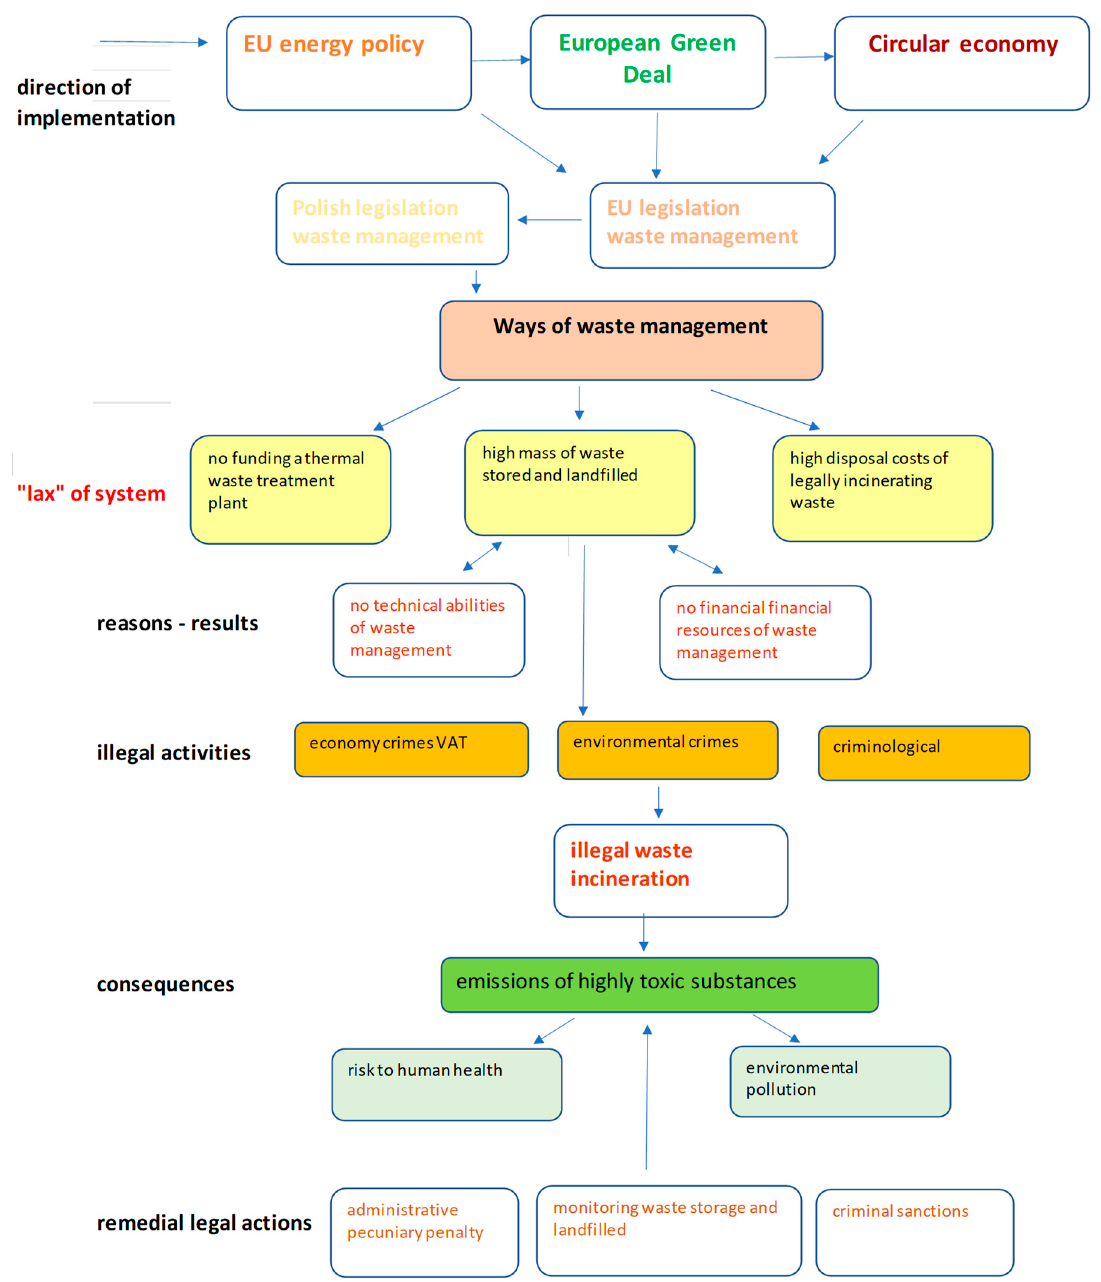
Figure 4. Diagram of the industrial waste management system in Poland.